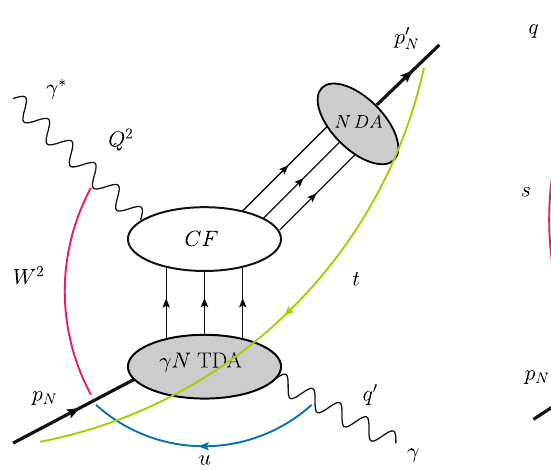
Fig. 1 Left panel: Collinear factorization mechanism for DVCS fixed τ (2); | u | ≡ | ( q (cid:4) − p N ) 2 | ∼ 0); γ N ( N γ ) TDA stands ( γ ∗ N → N (cid:4) γ ) in the near-backward kinematical regime (large − q 2 ≡ for the transition distribution amplitudes from a nucleon-to-a-photon (photon-to-a-nucleon); N DA stands for the nucleon distribution ampli- Q 2 , W 2 ≡ ( p N + q ) 2 ; fixed x B = Q 2 ; | u | ≡ | ( p N − q (cid:4) ) 2 | ∼ 0). 2 p N · q tude; CF and CF (cid:4) denote hard subprocess amplitudes (coefficient Right panel: Collinear factorization of TCS ( γ N → γ ∗ N (cid:4) ) in the near- backward kinematical regime (large q (cid:4) 2 ≡ Q (cid:4) 2 , W 2 ≡ ( p N + q ) 2 ;